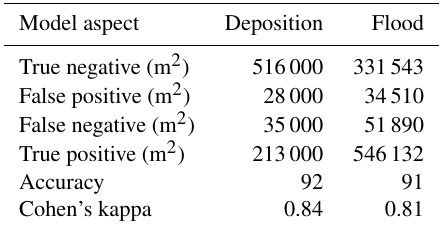
Table 6. Confusion matrix, accuracy, and Cohen’s kappa values for the debris flow deposition and flooding of the Min